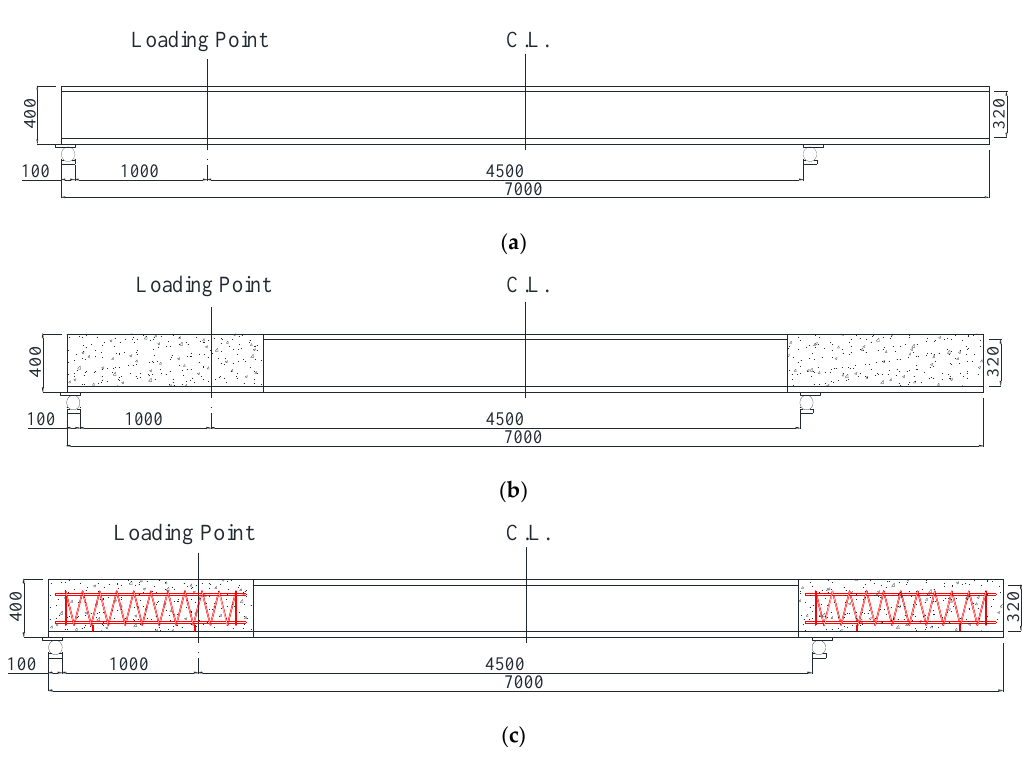
Figure 2. Longitudinal section views of test specimens. (Unit: mm). ( a ) A-A section of the NR—0/4 specimen. ( b ) B-B section of NR—2/4 and NR—4/4 specimens. ( c ) C-C section of LR—2/4 and HR—0/4 specimens. Table 3. Mix proportions of concrete.